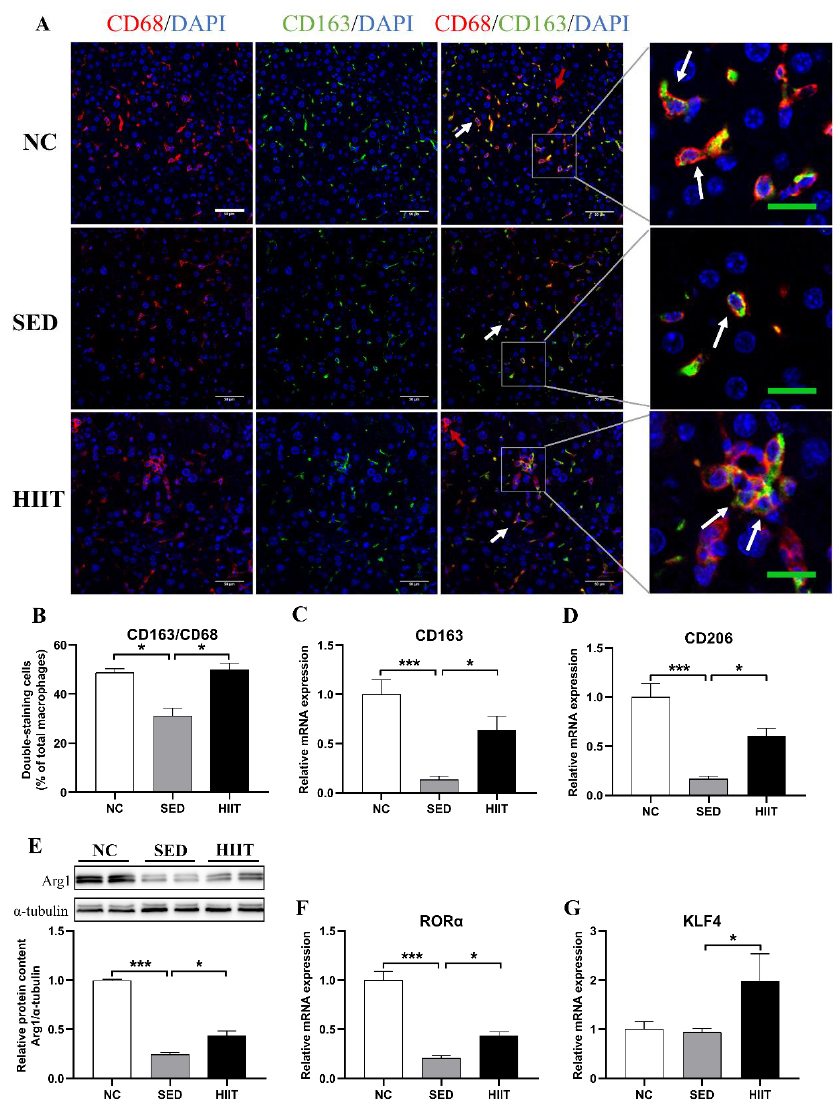
Figure 6. HIIT increases the anti-inflammatory polarization of liver macrophages in T2DM mice. ( A ) CD163/CD68 (M2) immunofluorescence double-labeling results. ( B ) Percentage of CD163/CD68- positive cells (n = 3 per group). ( E ) Protein expression of Arg1 and the internal control α -tubulin in the liver (n = 4 per group). ( C , D , F , G ) The mRNA expression levels of CD163, CD206, ROR α and KLF4 (n = 8 per group) . The white scale is 50 μm. The green scale is 20 μm. The red arrow indicates CD68 single-positive cells. The white arrow indicates CD163 and CD68 double-positive cells. Values are mean ± SEM. * p < 0.05, *** p < 0.001.